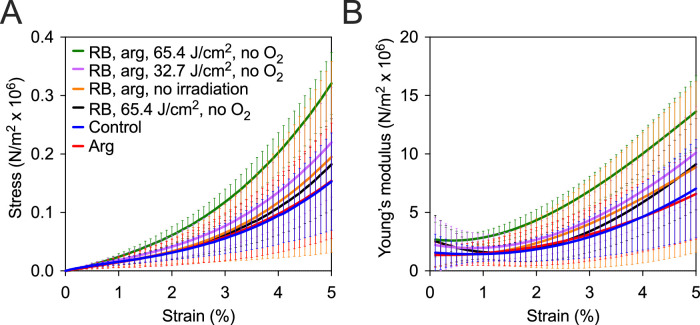
Effect of varying the fluence of green light on the tensile strength increase induced by RB photosensitized cornea crosslinking. All corneas were irradiated in the absence of oxygen except the three controls (no treatment, arg only, and RB, arg) were not irradiated and (A) stress-strain curves from tensile strength testing and (B) Young's modulus versus percent strain.